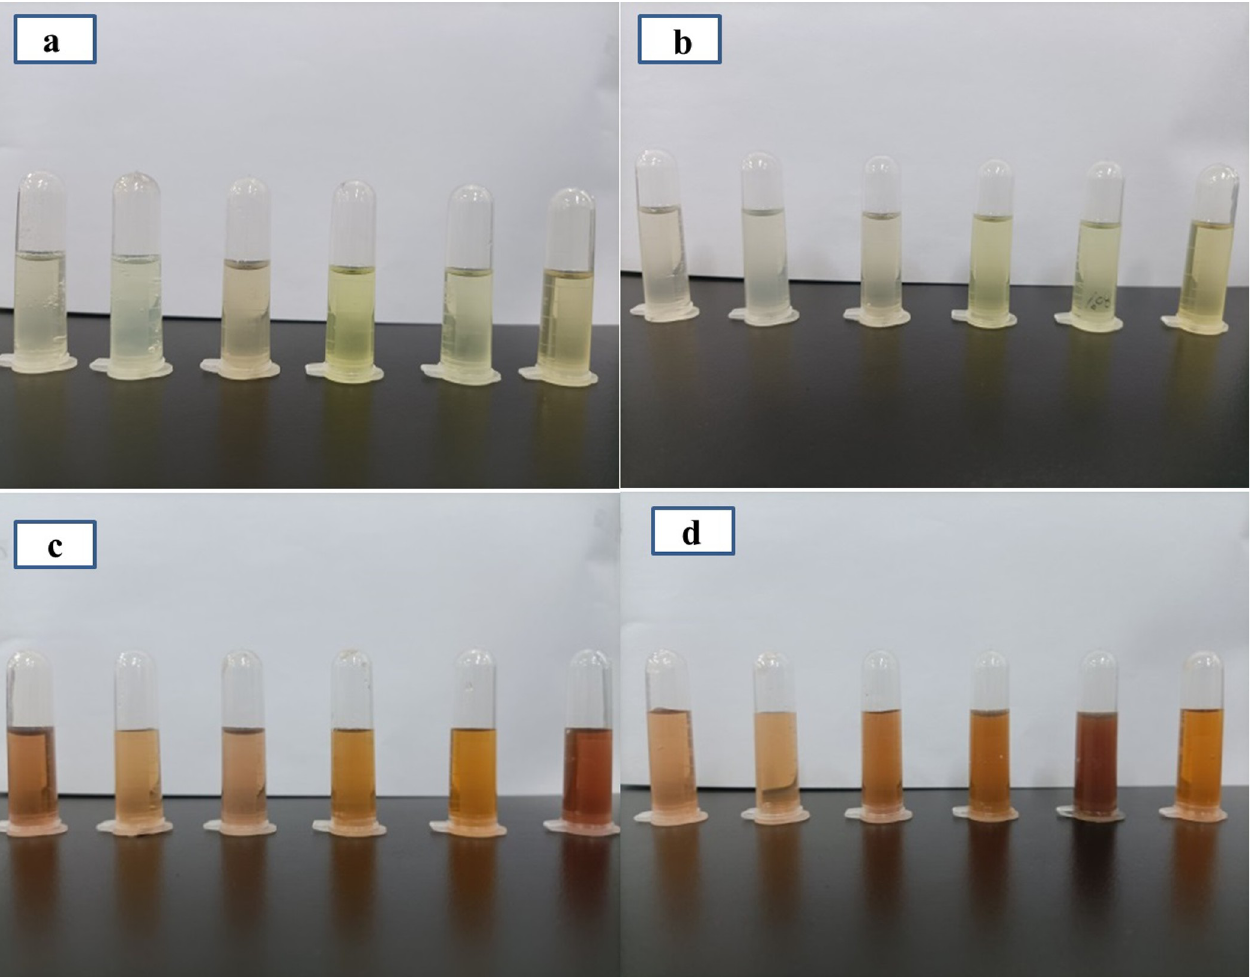
Fig 1. The solution appearance of Z . officinale root extract and synthesized Z . officinale AgNPs: (a) fresh ginger extract; (b) dry ginger extract; (c) fresh ginger extract AgNPs; (d) dry ginger extract AgNPs. Fig 1a and 1b from left to right was followed as the unpeeled ginger water extract, peeled ginger water extract, ginger peel water extract, unpeeled ginger ethanol extract, peeled ginger ethanol extract and ginger peel ethanol extract; Fig 1c and 1d from left to right are the unpeeled ginger water extract AgNPs, peeled ginger water extract AgNPs, ginger peel water extract AgNPs, unpeeled ginger ethanol extract AgNPs, peeled ginger ethanol extract AgNPs and ginger peel ethanol extract